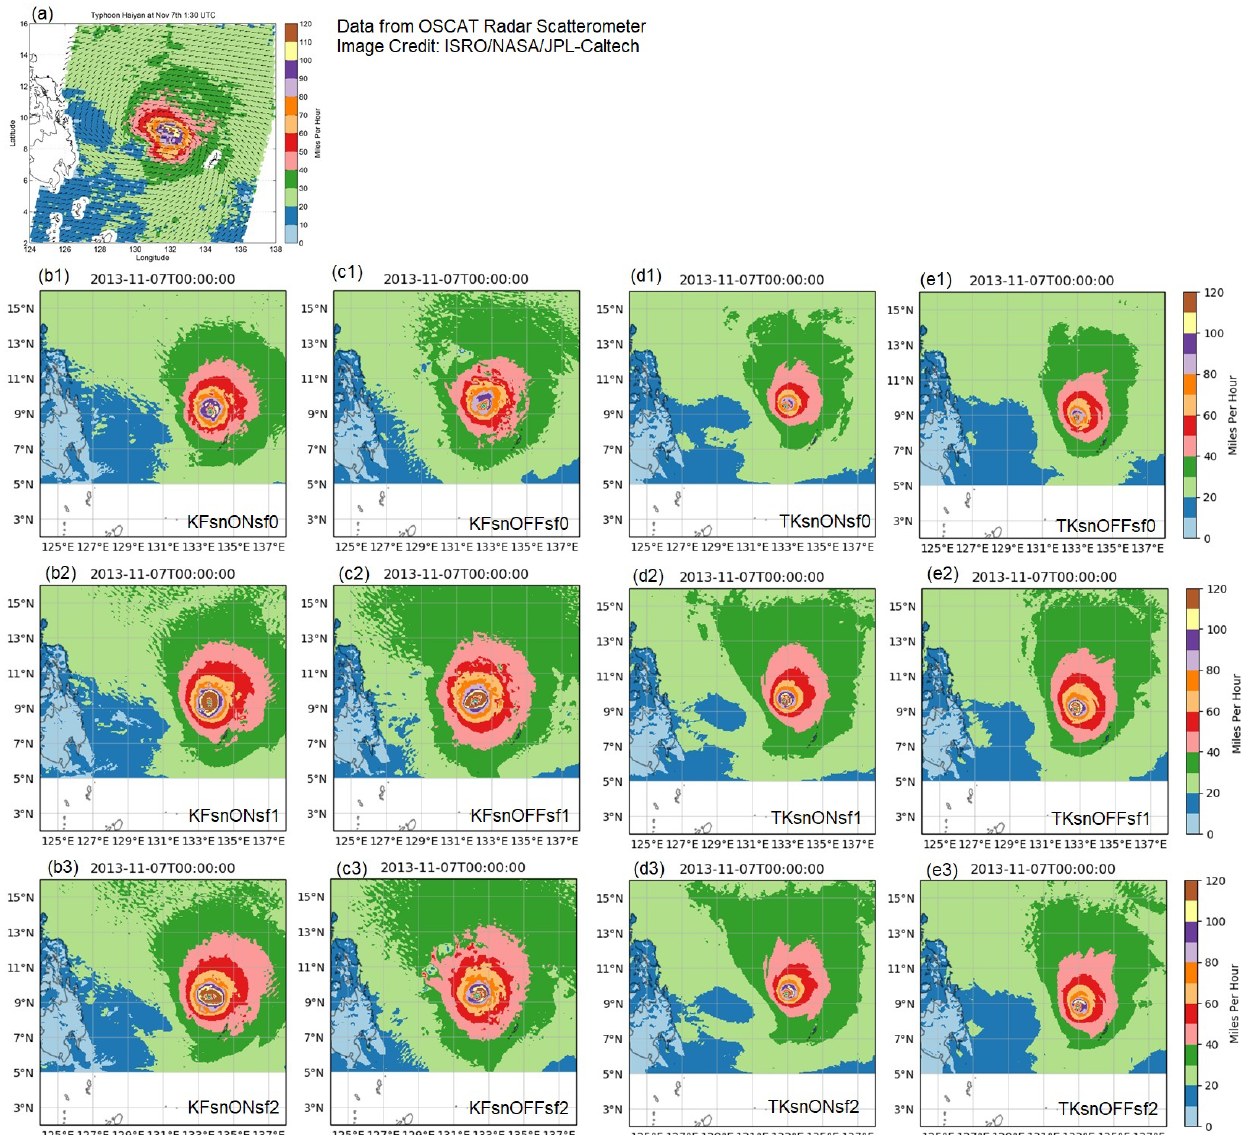
Figure 8. Surface winds (miles per hour, mph) (a) from the OSCAT radar scatterometer on the Indian Space Research Organization’s OceanSat-2 satellite at 01:30UTC on 7 November 2013 and (b–e) for each of the experiments at 00:00UTC on 7 November 2013. Source of Fig. 8a: https://www.jpl.nasa.gov/images/super-typhoon-haiyan (last access: 10 March 2021). Use is covered by https://www.jpl.nasa.gov/ jpl-image-use-policy (last access: 12 December